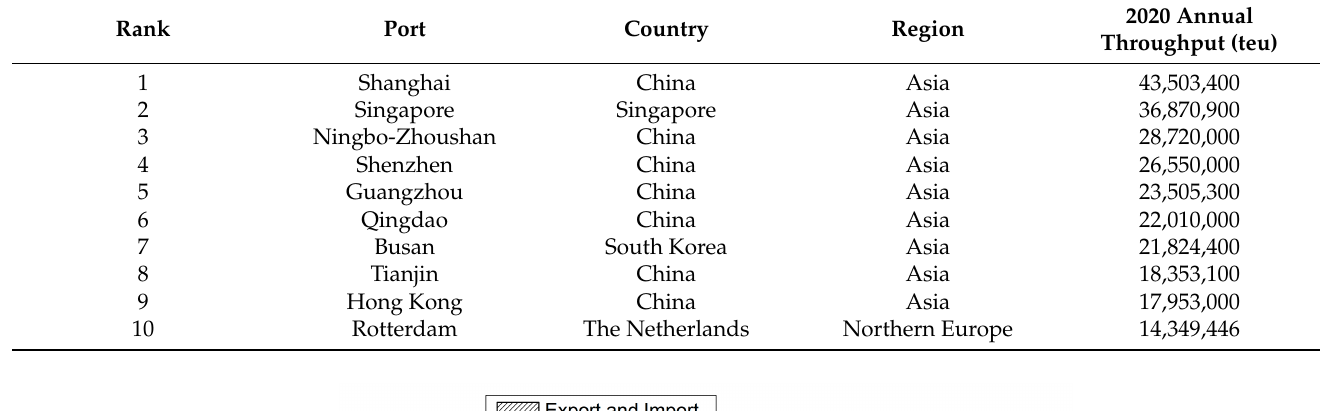
Table 2. The top 10 ports by throughput in 2020 (adapted from One Hundred Port 2021) [43].